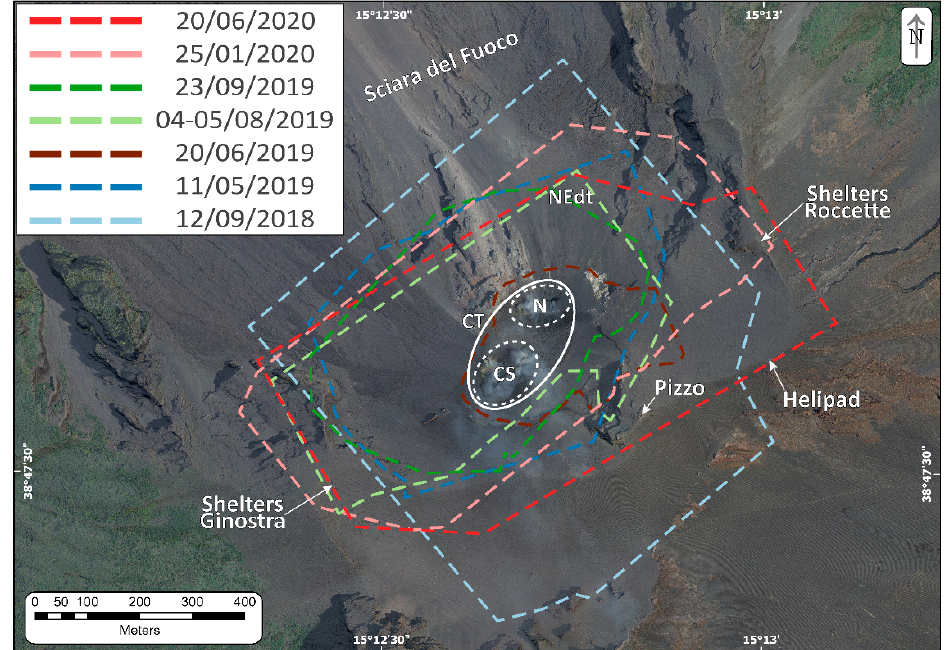
Figure 2. Map of Stromboli summit area showing the extent of the photogrammetric surveys of the crater terrace carried out in this work. CT, CS, N, and NEdt stand for crater terrace, central-south crater area, north crater area and north-east debris talus,